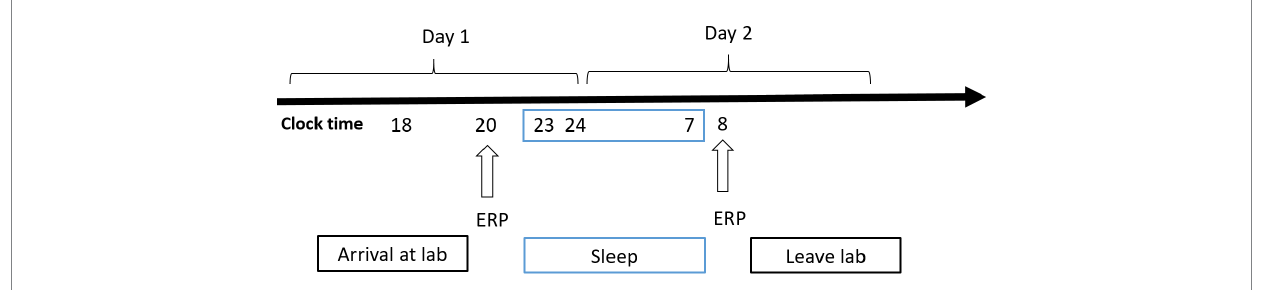
FIGURE 2 Experimental design for the nocturnal sleep (NS) group. Participants completed the tasks twice: before and after 8 h of sleep in the laboratory. Electroencephalographic data were recorded simultaneously. The arrows indicate various time points during the 2-back working memory task.